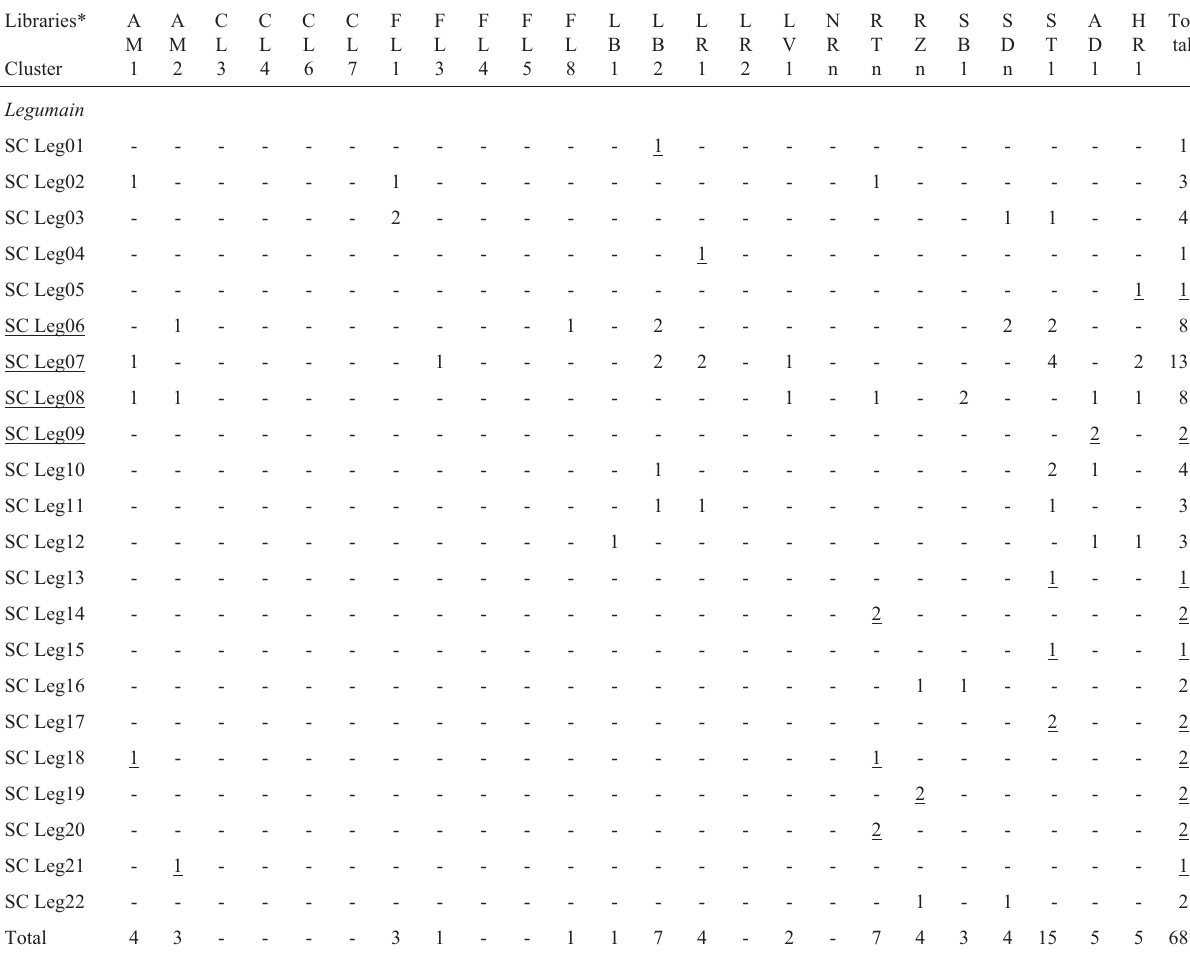
Table V - Frequency of sugarcane legumain related reads and clusters on sugarcane cDNA